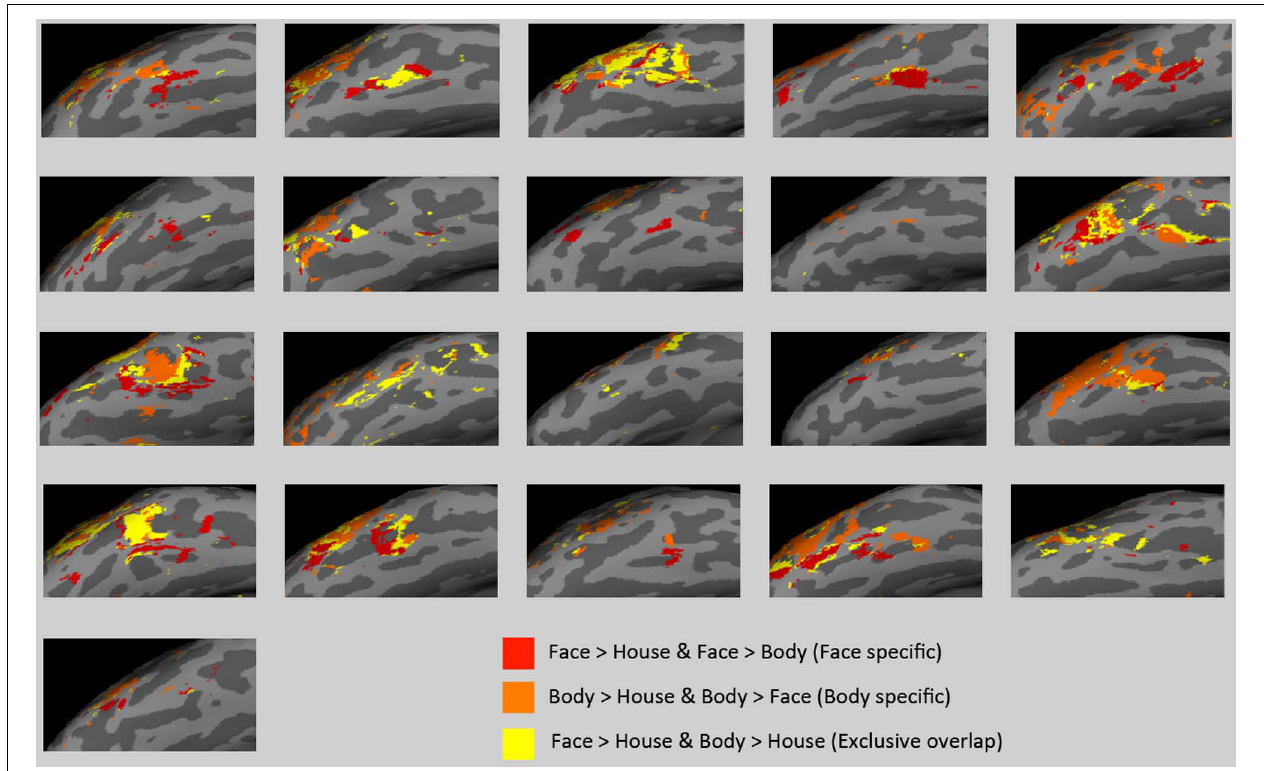
FIGURE 6 |Activations in subject space. “Face specific” (red) and “body specific” (orange) regions for each of the 21 subjects are displayed, along with “exclusive overlap” (yellow) regions where face > house and body > house but faces are not different from bodies.